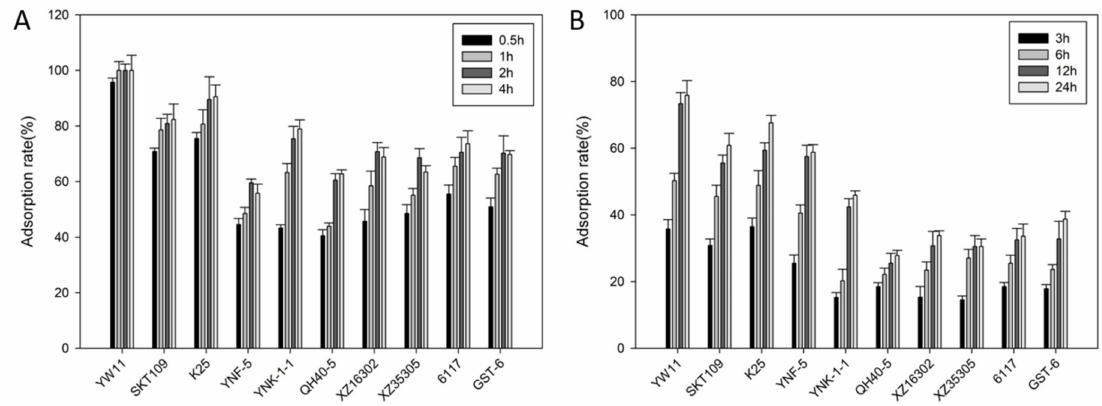
Figure 1. Lead absorption rates from aqueous solution ( A ) and MRS (de Man, Rogosa, and Sharpe) broth ( B ) by di ff erent lactic acid bacteria strains: Bars show the mean ± SE (standard error) of three biological replicates.